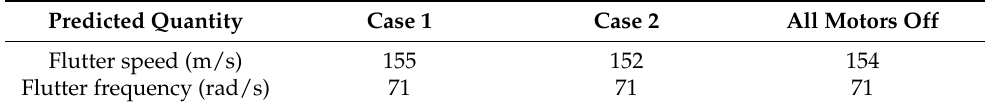
Table 3. Flutter speed and frequency of the wing for case 1 and case 2. Predicted